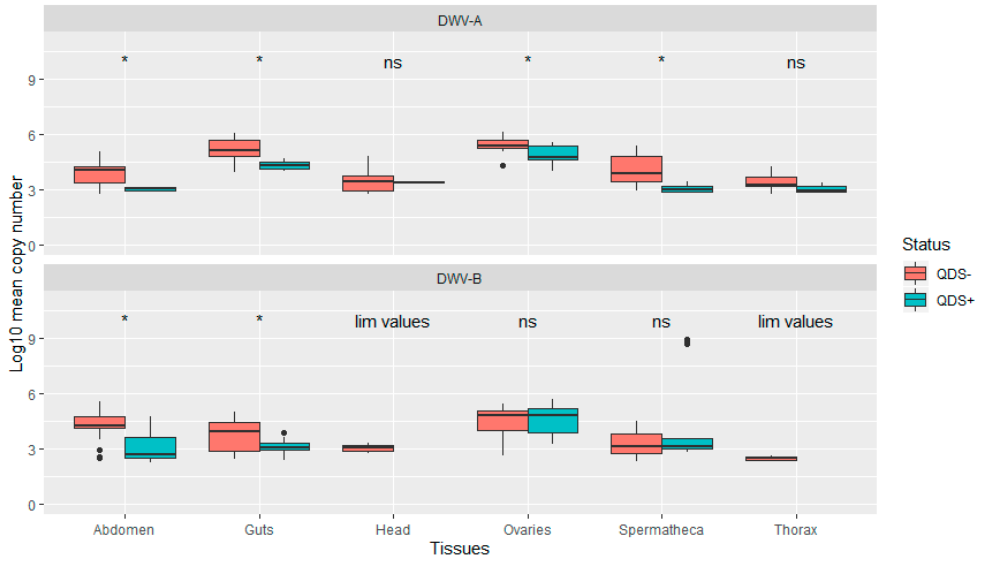
Figure 3. Boxplot of the infection load per tissue for DWV-A and DWV-B. Data are presented as Log10 copy number per sample for QDS+ (green) and QDS – (red). Significant differences between both groups are indicated at the top of each tissue with *, non-significant differences with ns. For the head and thorax insufficient samples were infected with DWV-B for statistical analyses (lim values).